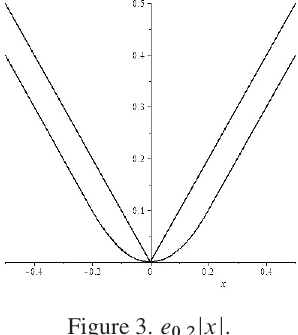
Figure 3. e 0:2 j x j